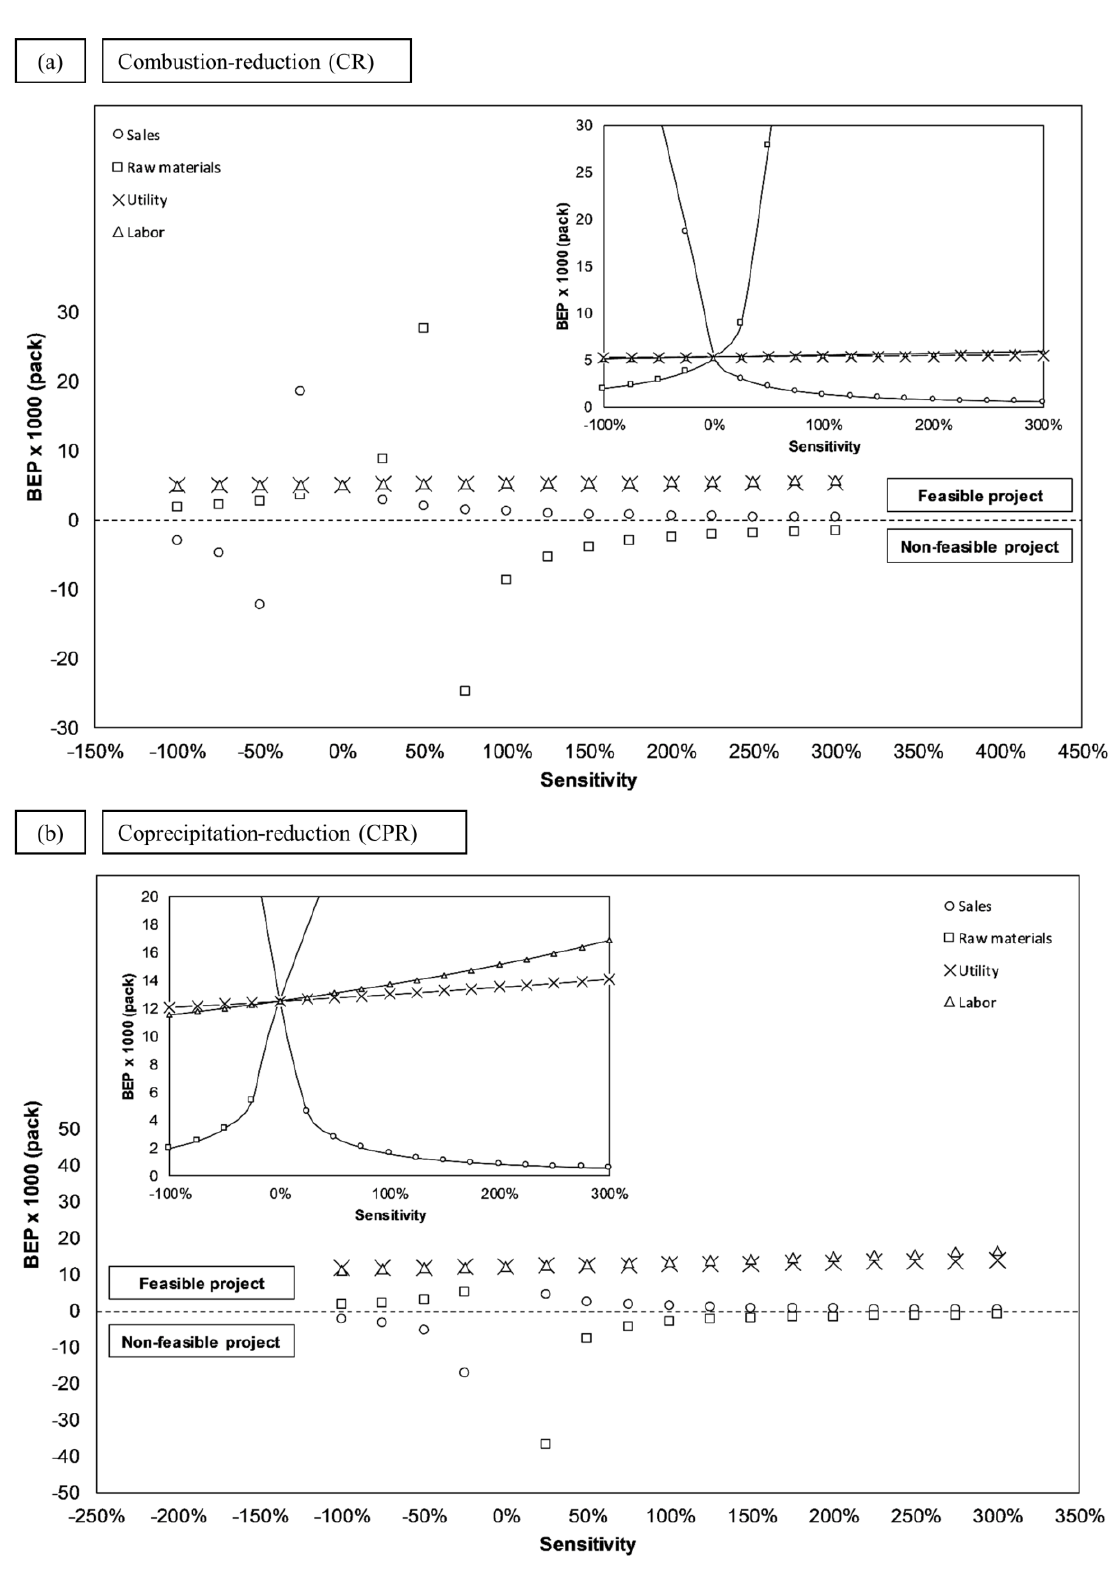
Fig. 8. Analysis of BEP as a function of sales, raw materials, utility, and labor for (a) combustion-reduction (CR) and (b) coprecipitation-reduction (CPR). An insert image is the analysis of BEP in the specific range (-100% to